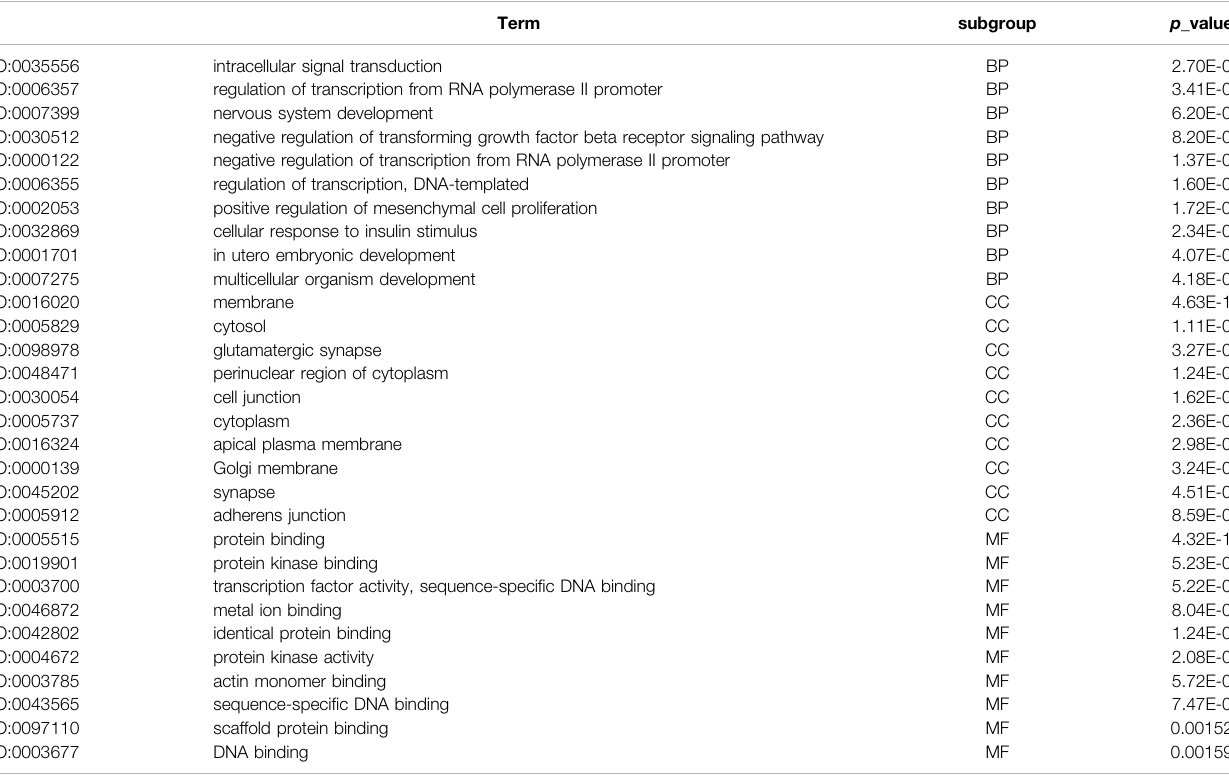
BP, biological process; CC, cellular component; MF, molecular function.